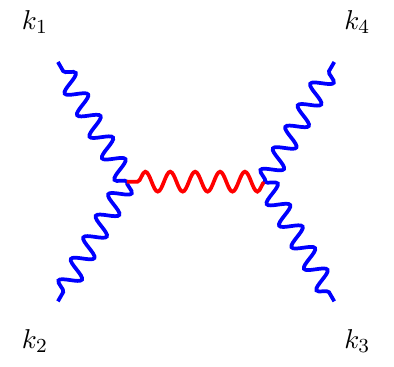
Figure 6 . Four graviton amplitude due to exchange of a massive spinning particle.